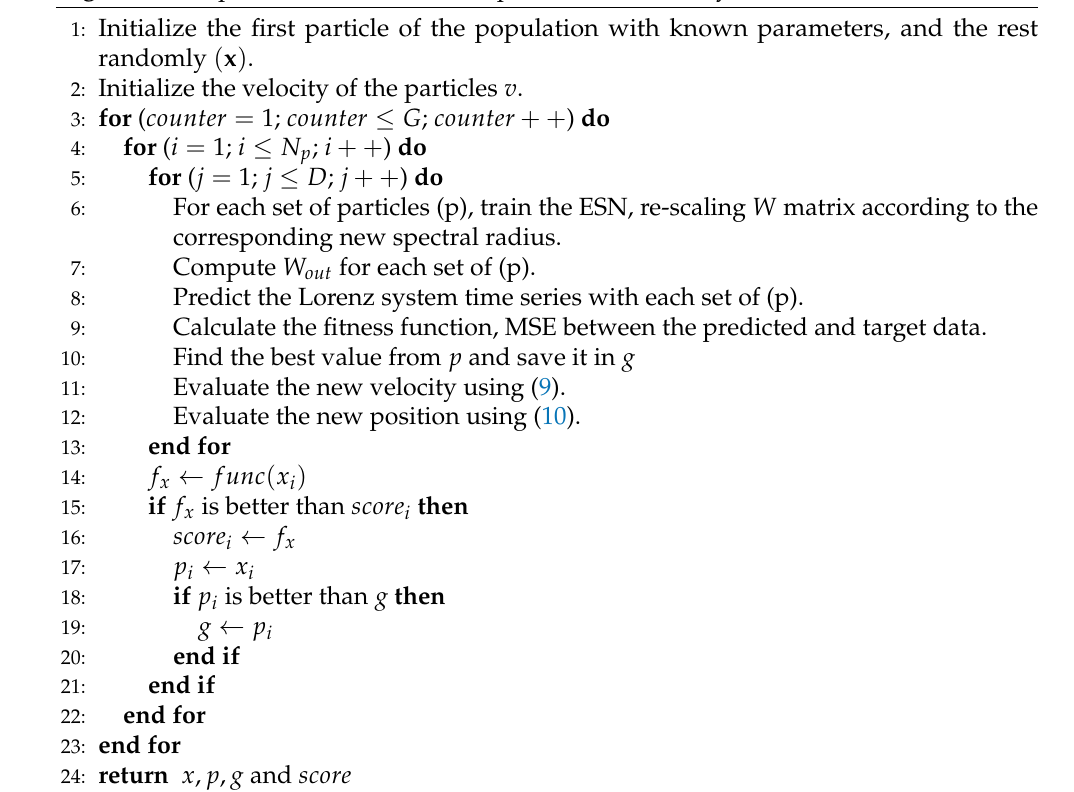
Algorithm 1 Optimization of an ESN to predict the Lorenz system with